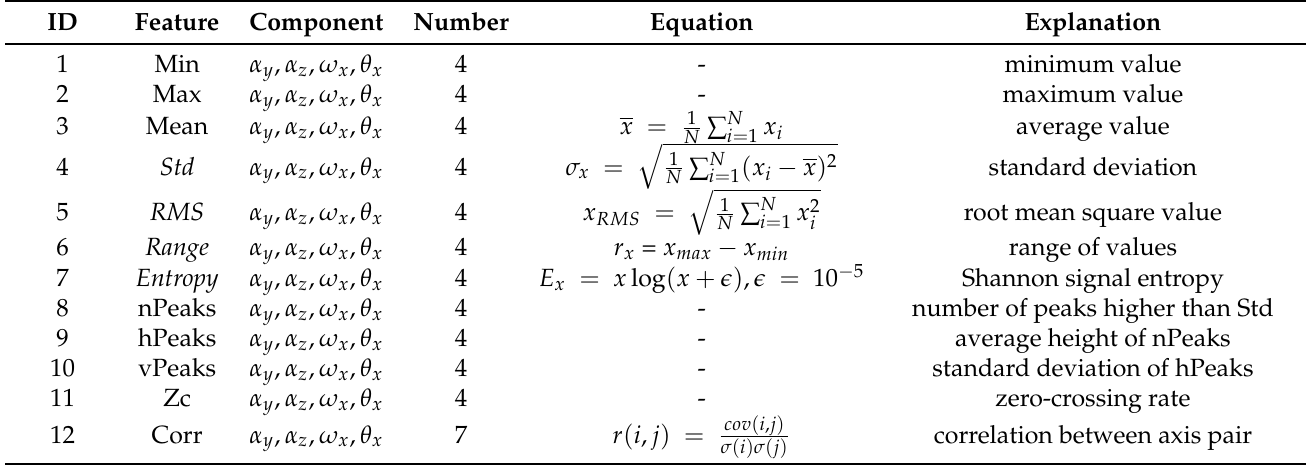
Table 4. List of time-domain features extracted in the present study, together with equations and some brief explanations. α : acceleration; ω : angular velocity; θ : orientation.